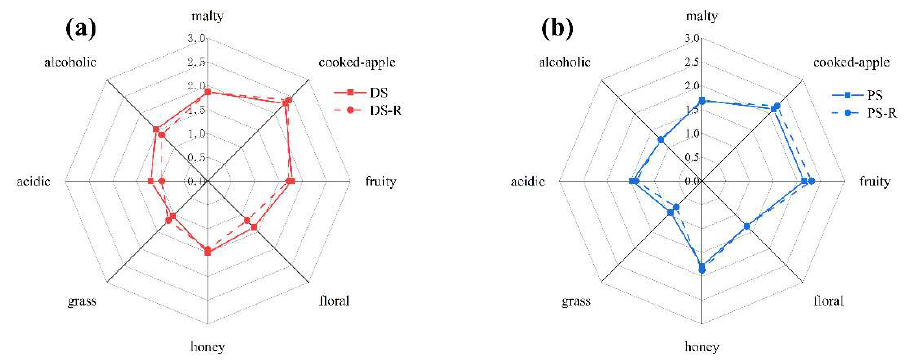
Figure 3. Radar diagram of aroma profiles of original spirit and its reconstitution solution. ( a ) Aroma profiles of DS and its reconstitution. ( b ) Aroma profiles of PS and its reconstitution.